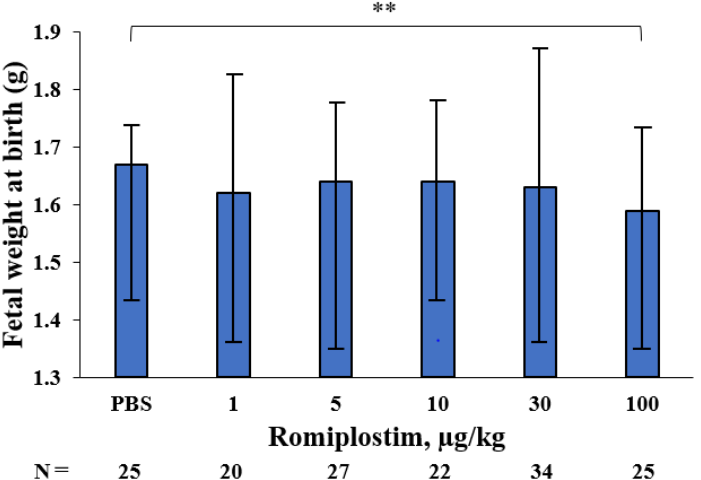
Figure 3. MK in maternal femoral bone marrow and fetal liver. Femoral bone marrow histology (H&E) in the control pregnant mice ( A ) and pregnant mice treated with 100 µg/kg romiplostim ( B ) on GD18. Liver histology (H&E) of fetuses of control pregnant mice ( C ) and of pregnant mice treated with 100 µg/kg romiplostim ( D ). The black arrowheads mark megakaryocytes. Scale bars 50 µm, 20 magnification. ( E ) MK frequency (the total number of MKs divided by the total number of scorable fields) under 20 magnification is shown for PBS, 1, 5, 10, 30, and 100 µg/kg romiplostim in fetal liver section triplicate experiments (N = 5). Bars represent the median. Error bars represent range. ** p < 0.01.